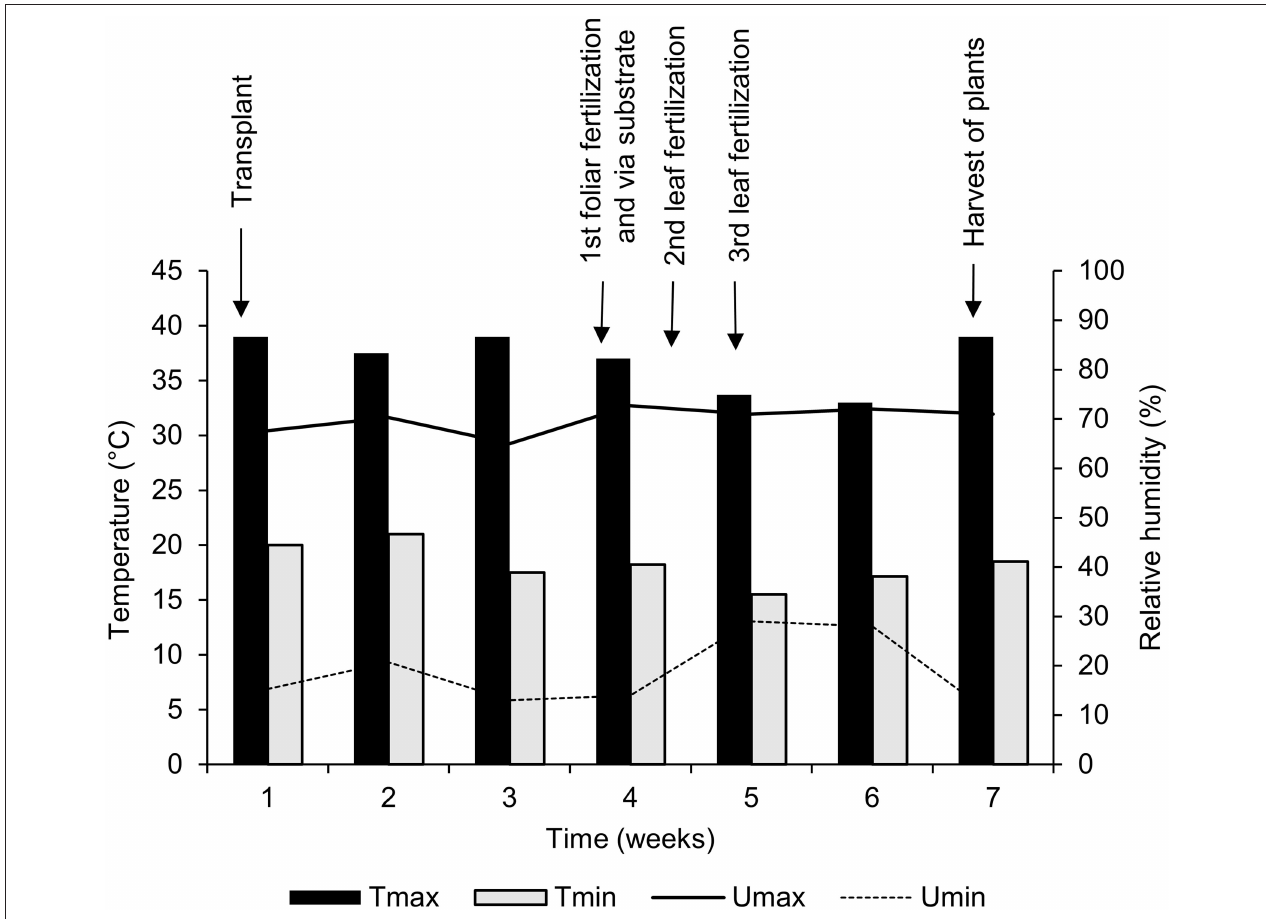
FIGURE 1 | Maximum ( T max ) and minimum ( T min ) air temperature, and maximum ( U max ) and minimum ( U min ) relative humidity inside the greenhouse throughout the experimental